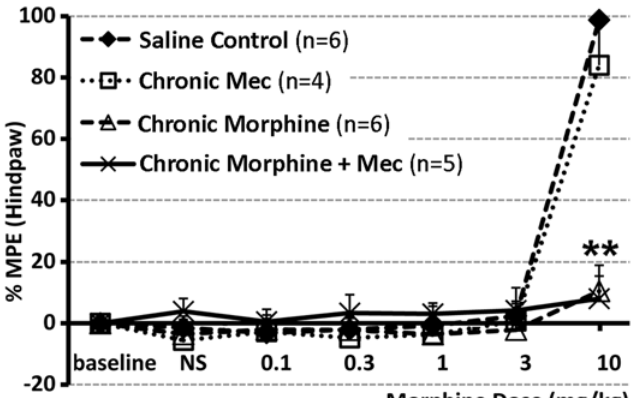
Fig 3. Behavioral Analysis of Rat Antinociceptive Tolerance with Hot-Plate Test. Hot Plate test was done in the afternoon on day 7 of treatment to evaluate development of antinociceptive tolerance. Chronic morphine administration (10 mg/kg sc twice-daily for 6.5 days; n = 6) was associated with development of antinociceptive tolerance in comparison to saline control group (n = 6). Chronic mecamylamine ( Mec ) administration (2 mg/kg sc twice-daily for 6.5 days; n = 4) did not change morphine antinociceptive effect. In addition, when given chronically with morphine, mecamylamine did not change development of antinociceptive tolerance (n = 5). Results are presented as a percentage of maximum possible effect ( %MPE ± SD) according to the method of Harris and Pierson [38] to construct dose-response curves for morphine ’ s antinociceptive effect. Two-way ANOVA shows a significant effect of morphine ( F (1,17) = 377.69, p < 0.0001 at 10 mg/kg testing dose), while there is no significant effect of mecamylamine nor interaction effect. ** , p <